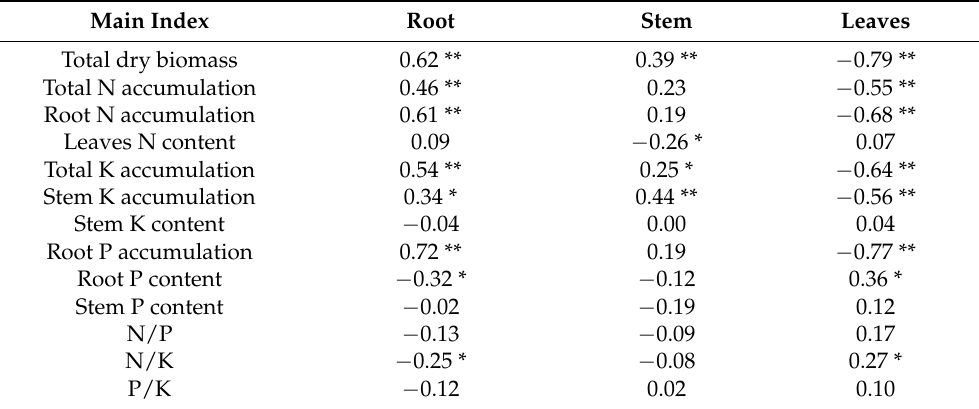
Table 10. Correlation analysis of dry biomass content and accumulation in each organ and main indices of P. bournei seedlings under